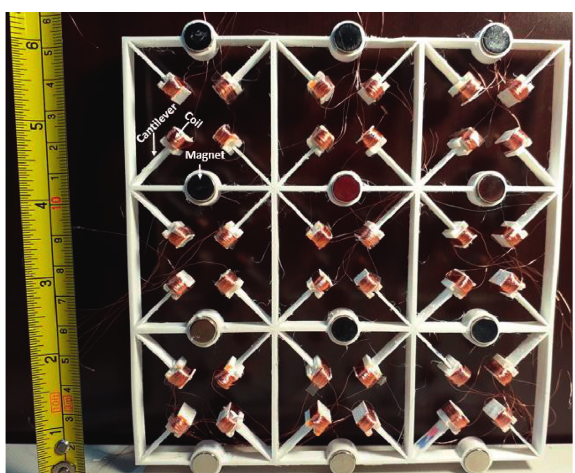
Figure 4: Prototype of the metamaterial vibration attenuation energy harvesting structure presented in this work.